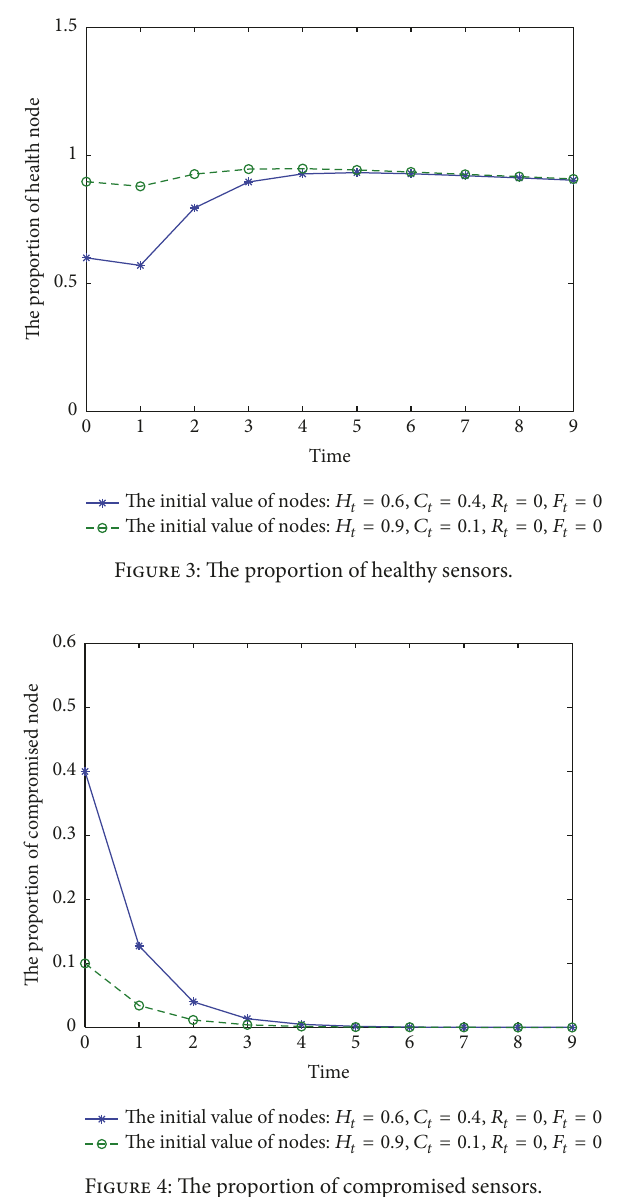
Figure 4: The proportion of compromised sensors.